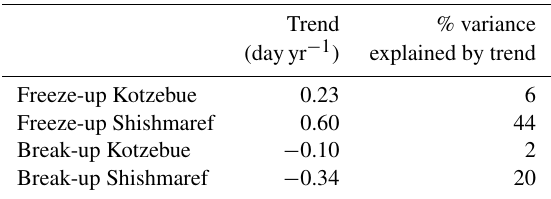
Table 1. Variance of freeze-up and break-up